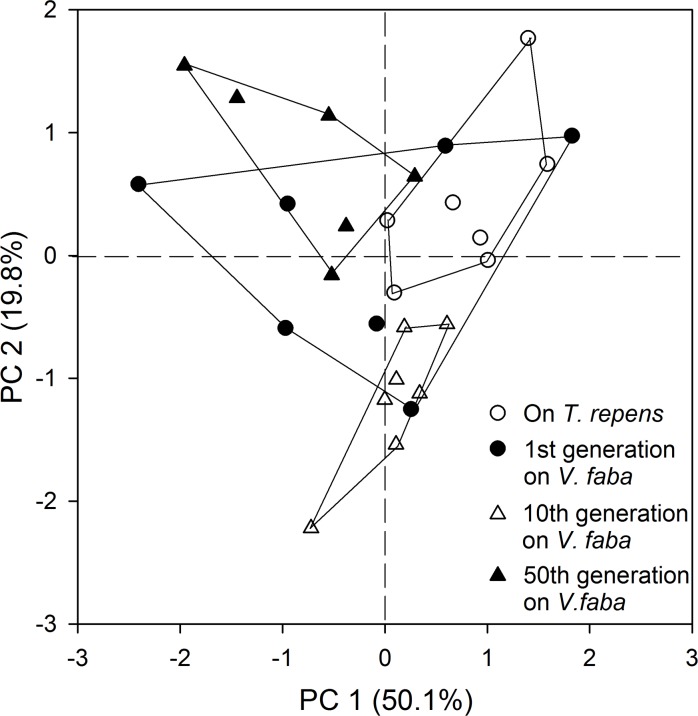
Principal components analysis (PCA) based on CHC composition of A. pisum during host switching from T. repens to V. faba.Wingless adults of the RGS morph were used for SPME sampling with 7 μm PDMS fiber. Shown are score plots of PC 1 versus 2, with the percentage of total variance explained by each axis given in parentheses. Each symbol represents an aphid individual. Data points for each group are enclosed within a line.